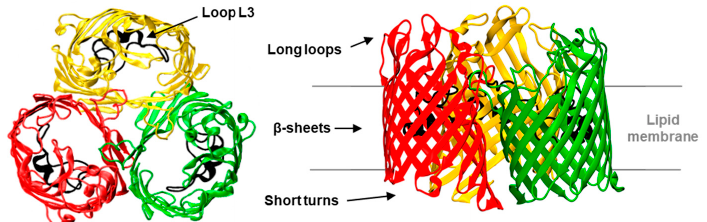
Figure 1. Three-dimensional structure of the OmpF (Outer membrane protein F) channel. View from the extracellular side (left panel) and side view (right panel) of the OmpF homotrimer (PDB code 2OMF). Each monomer is folded as a 16-stranded antiparallel β -barrel connected by eight long loops facing the extracellular side and eight short turns facing the intermembrane space. Loop 3 (shown in black) folds inside the barrel, creating a constriction zone (~1 nm) at half the length of the